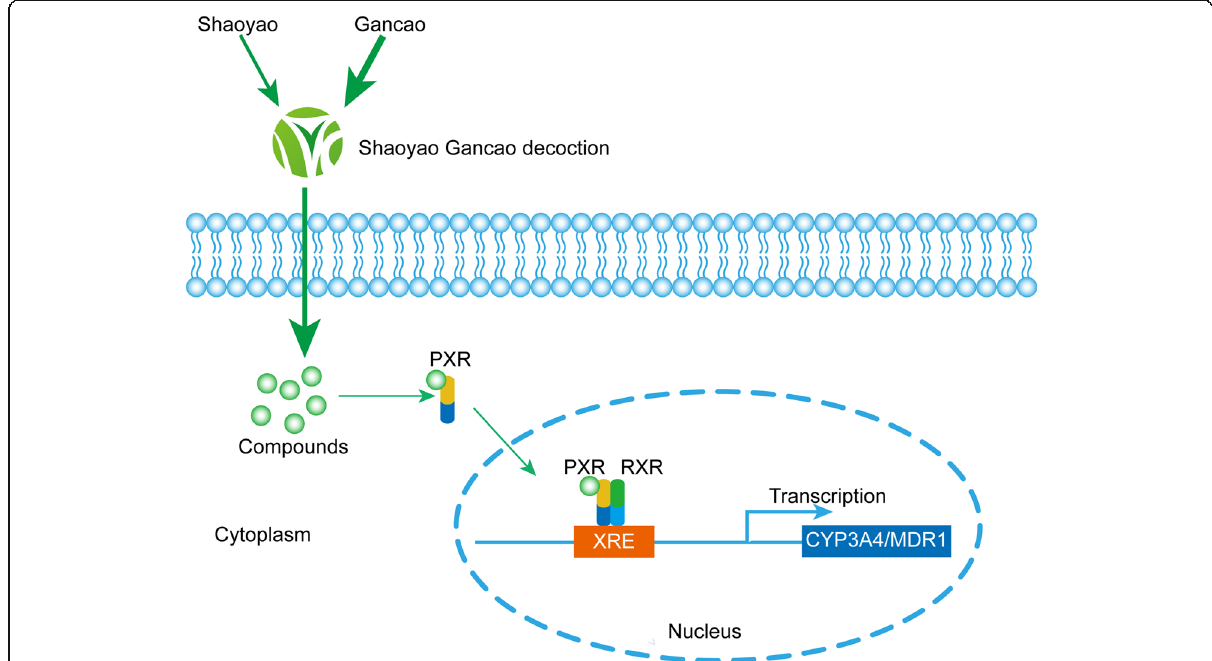
Fig. 6 The illustration of the present work. PXR translocates from the cytoplasm to the nucleus of the cells when bound to and activated by ligands, then activated PXR binds to target genes ’ DNA xenobiotic response elements (XREs) as a heterodimer or heterotetramer with the retinoid X receptor (RXR). Then induce the transcription of the target genes. PXR could be activated by SGD, and then bind to XREs of CYP3A4 and MDR1, induce